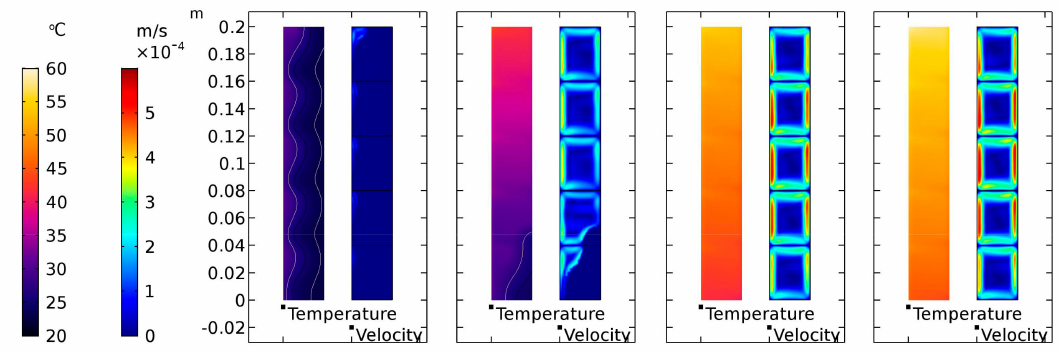
Figure 10. Results of the step 2 simulation for the unsegmented block after 4, 8, 12 and 16 h (from left to right); black line in temperature contour plot is the 25 ◦ C isotherm; white lines are the 23 ◦ C respectively 27 ◦ C isotherms.